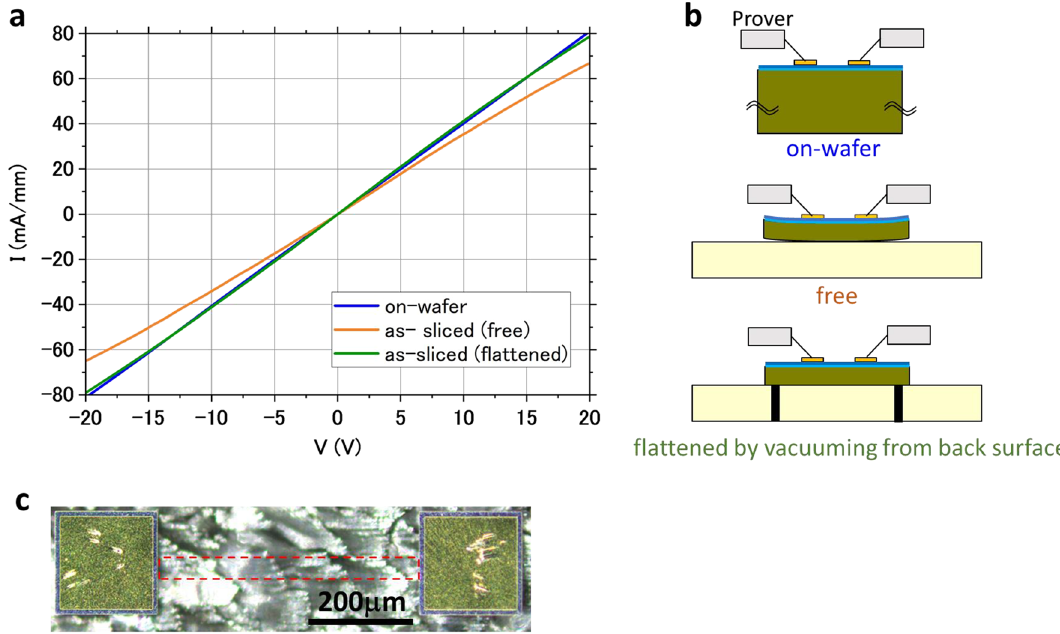
Figure 5. ( a ) I–V characteristics of 2DEG channel of various shapes. ( b ) Schematic of each measurement. ( c ) Optical microscopy image of measured device. The red dashed rectangle indicates the 2DEG channel